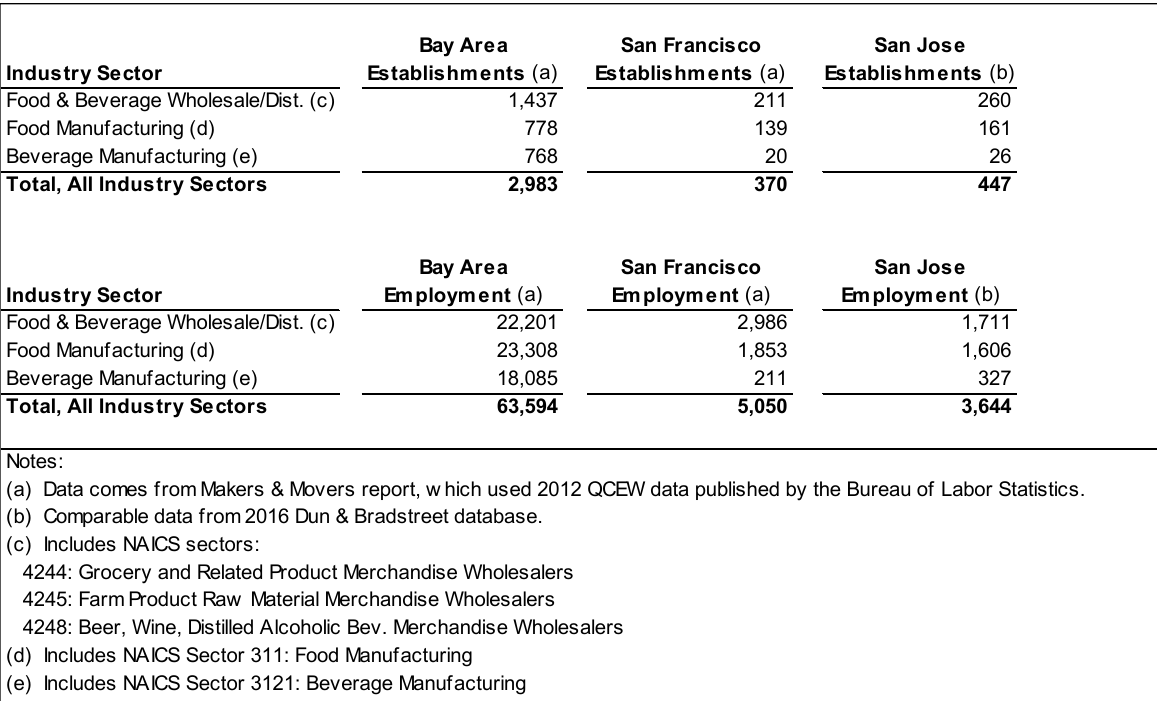
Reprinted from SAGE, 2016, Table 3.7; used with